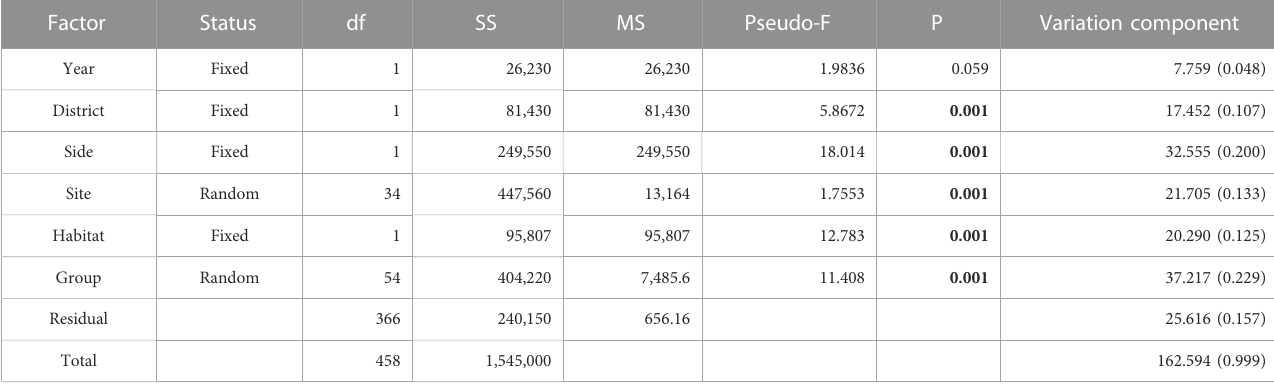
TABLE 4 Results from the Implicit Nested PERMANOVA model using a crossed design between unique coded random and fi xed factors and Type 1 sequential Sum of Squares. Year, District, Side, and Habitat are fi xed factors, each comprising two levels. Output terms were constrained to main factors by design, which facilitated designations of their exclusive variance components. Bold – p <